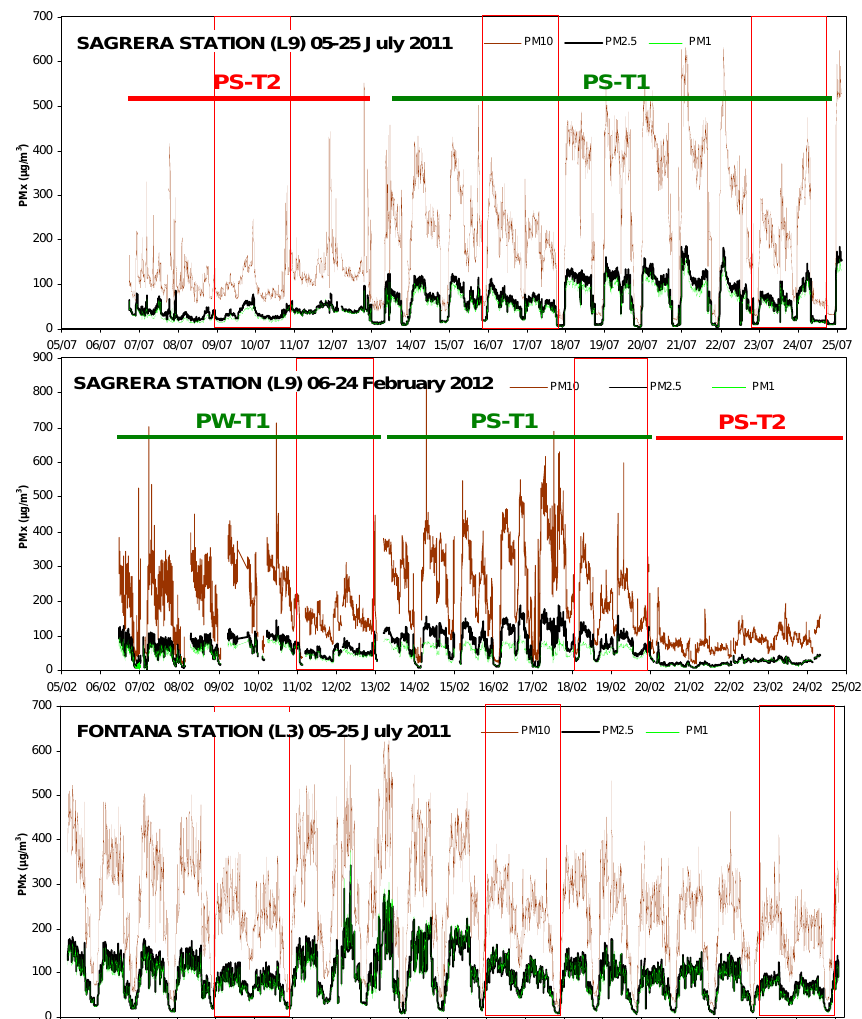
Fig. 3. Five minute PM 10 , PM 2 . 5 and PM 1 levels measured at the platforms of the Sagrera (S-L9) and Fontana (F-L3) stations. Red squares indicate weekend days and time is a.m. LT). Codes PS, PW, T1 and T2 are the ventilation schemes (see methodology